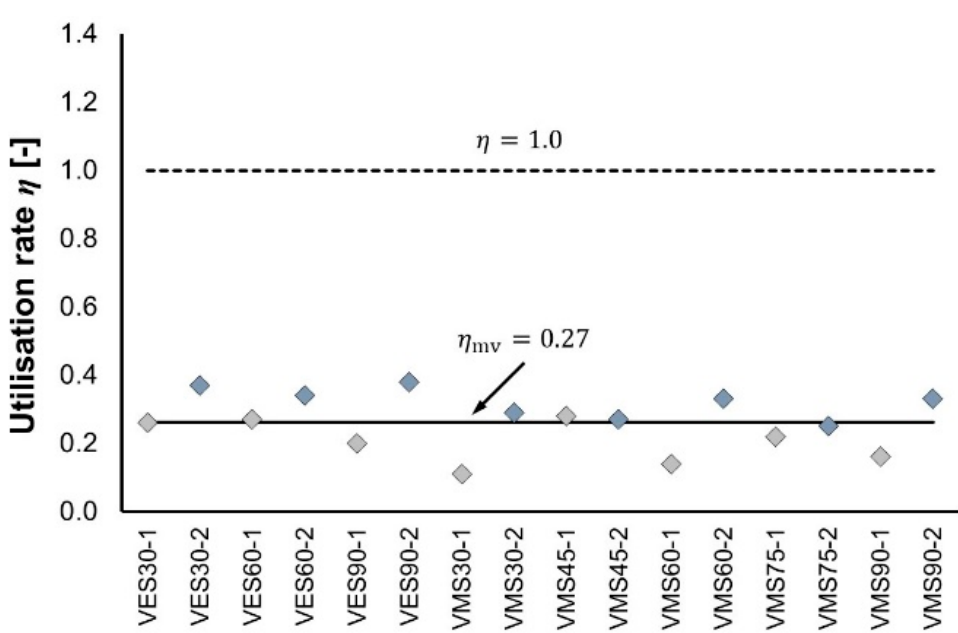
Figure 3. Calculated utilisation rate of pulled out fibres in UHPC under quasi-static loading and mean value.